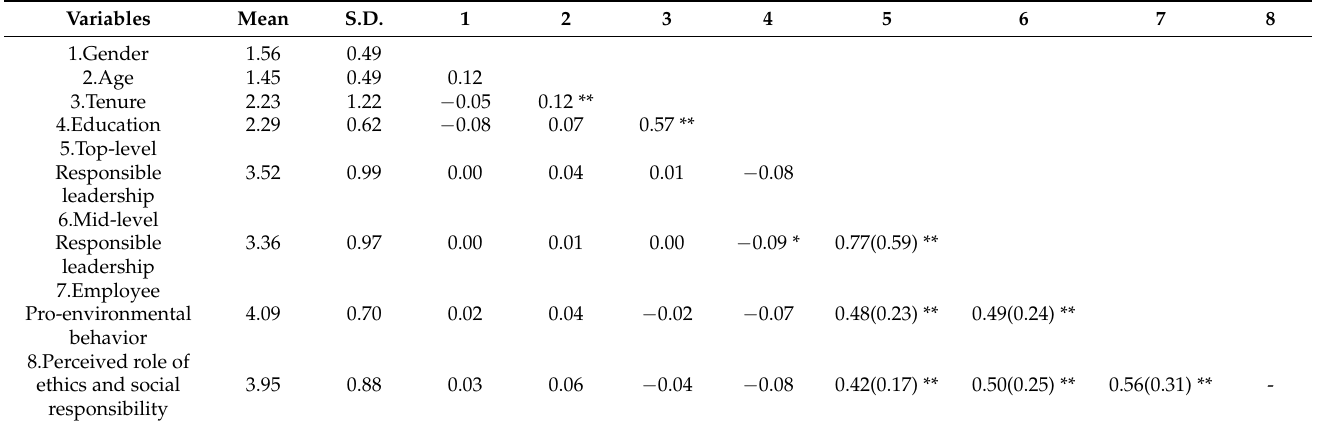
Table 3. Descriptive Statistics Results and Correlation Matrix (N =